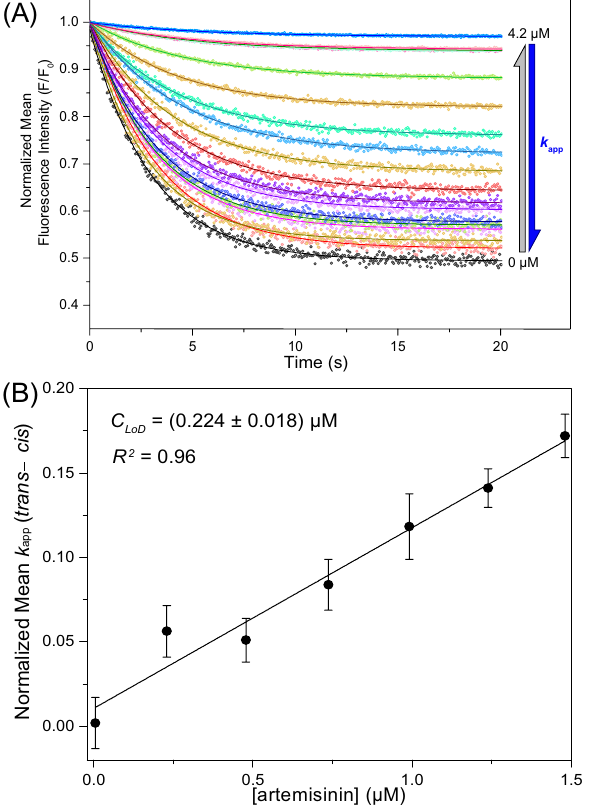
Figure 6. Detection of ART using the photochrome aptamer switch assay. Panel ( A ) displays fluorescence decay plots of 0.1 µM unbound MN19-SITS (black) and as a function of zero to 4.2 µM ART concentration (light blue). The MN19-SITS is continuously excited at 340 nm and the emission at 422 nm are simultaneously detected as a function of time. Each normalized decay plot is fitted to the first-order decay function (solid lines) to quantify the apparent trans – cis decay kinetics (Eq. 1; k app ). Panel ( B ) calibration plot for the normalized average k app values of MN19-SITS against ART concentrations. The concentration limit of detection (C LoD ) obtained is (0.22 ± 0.02) µM. Triplicated experiments were performed in 20 mM Tris (pH 7.4), 140 mM NaCl at 20 °C. The error bars correspond to one standard